Question: According to this chart, does the measure grow or shrink?
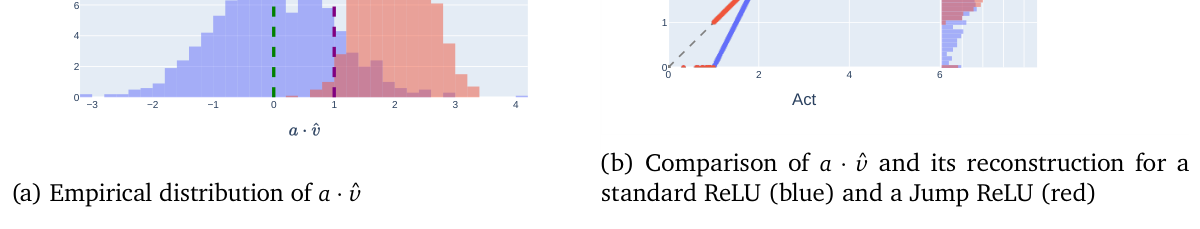
Answer: increasing